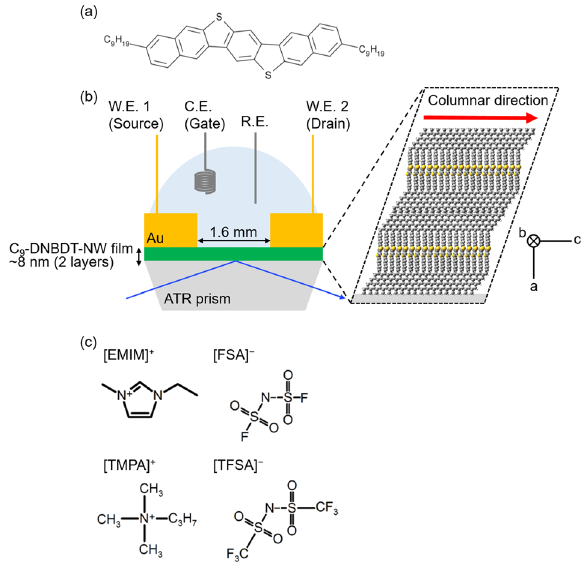
Fig. 1 A developed electrochemical ATR-UV spectroscopy for ILs-gated EDL-OFETs. a The structural formula of C 9 -DNBDT-NW. b A schematic illustration of the fabricated ILs-gated EDL-OFET on the ATR sapphire prism. c The structural formulae of ILs employed in this